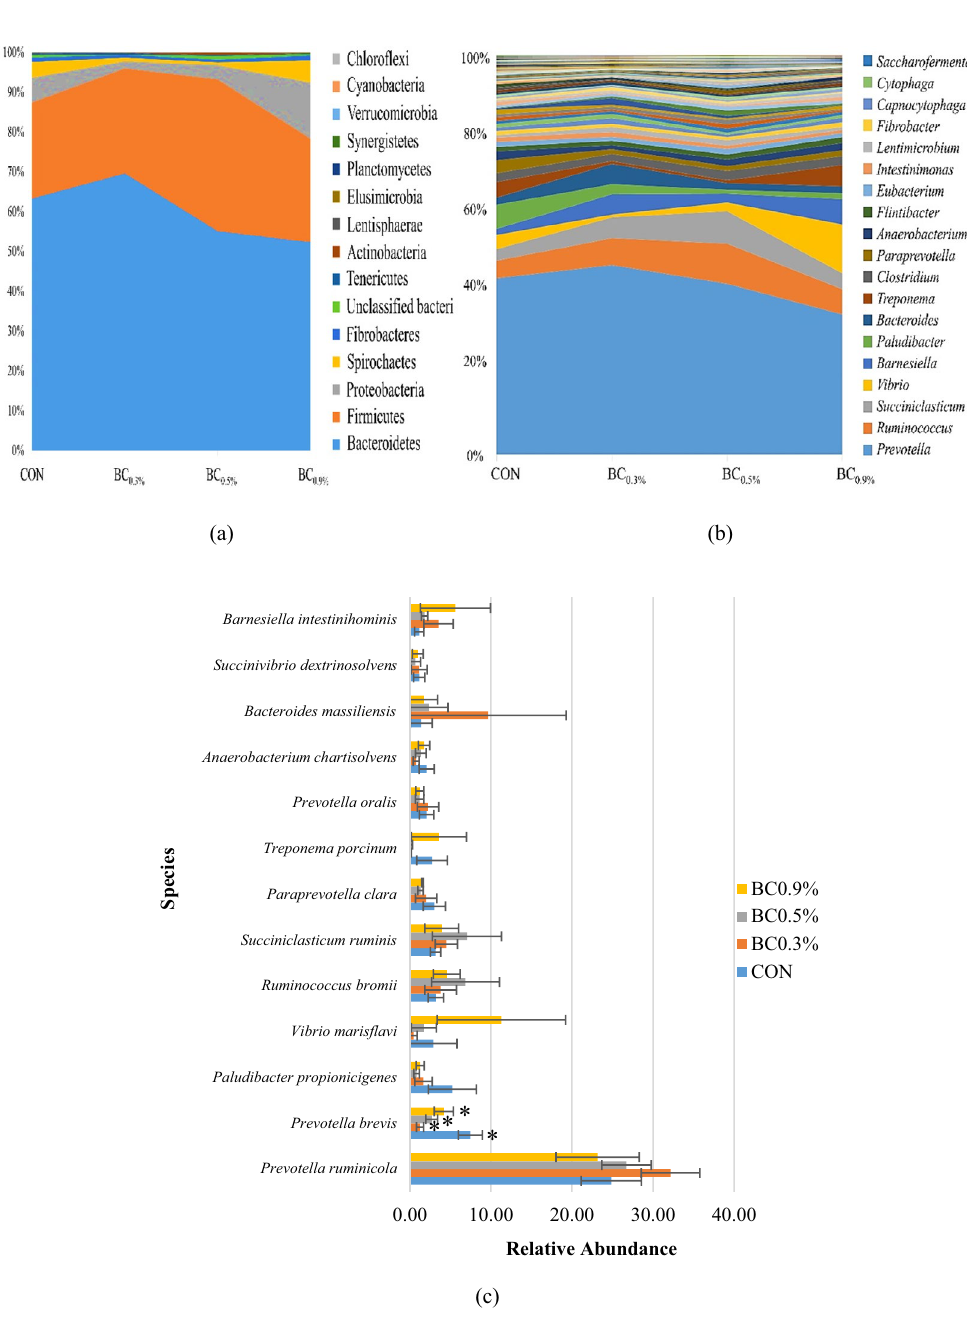
Figure 2. Relative abundance of the observed ( a ) phyla, ( b ) genera, and ( c ) species from the four different treatments. Mean relative abundances of bacterial phyla and genera are presented in supplementary Table 2. Relative abundance was computed using QIIME 25 . CON (no buffer added); BC 0.3% (0.3% buffer); BC 0.5% (0.5% buffer); BC 0.9% (0.9% buffer); asterisk (*): represents significant differences ( P <